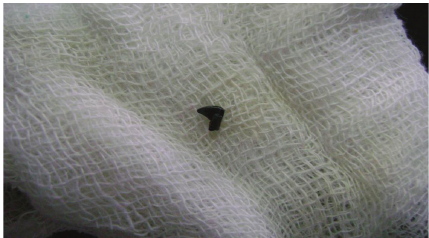
Figure 2: Removed tip of the metallic compass.